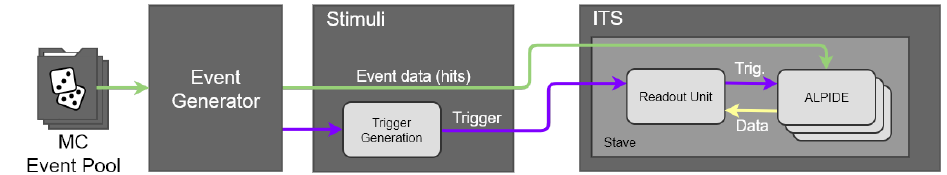
Figure 3: Overview of SystemC simulation model for